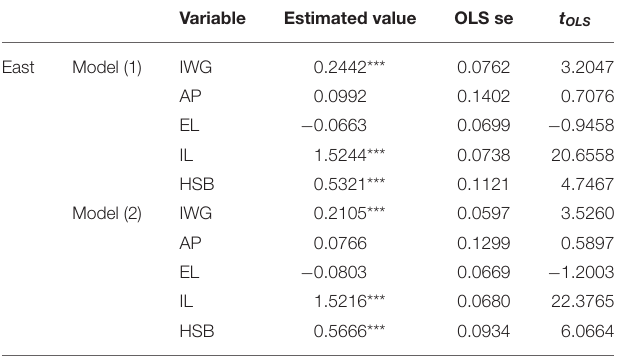
TABLE 1 | Descriptive statistics of the variables. Mean Maximum Minimum Std. dev.